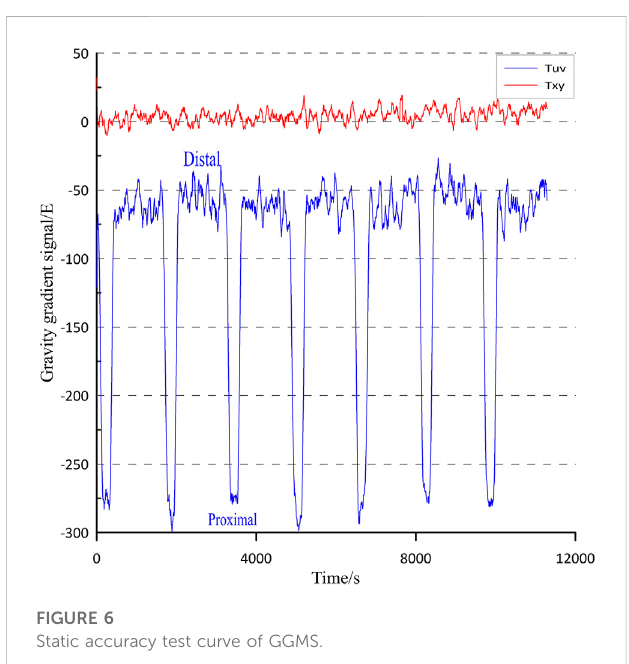
FIGURE 6 Static accuracy test curve of GGMS.